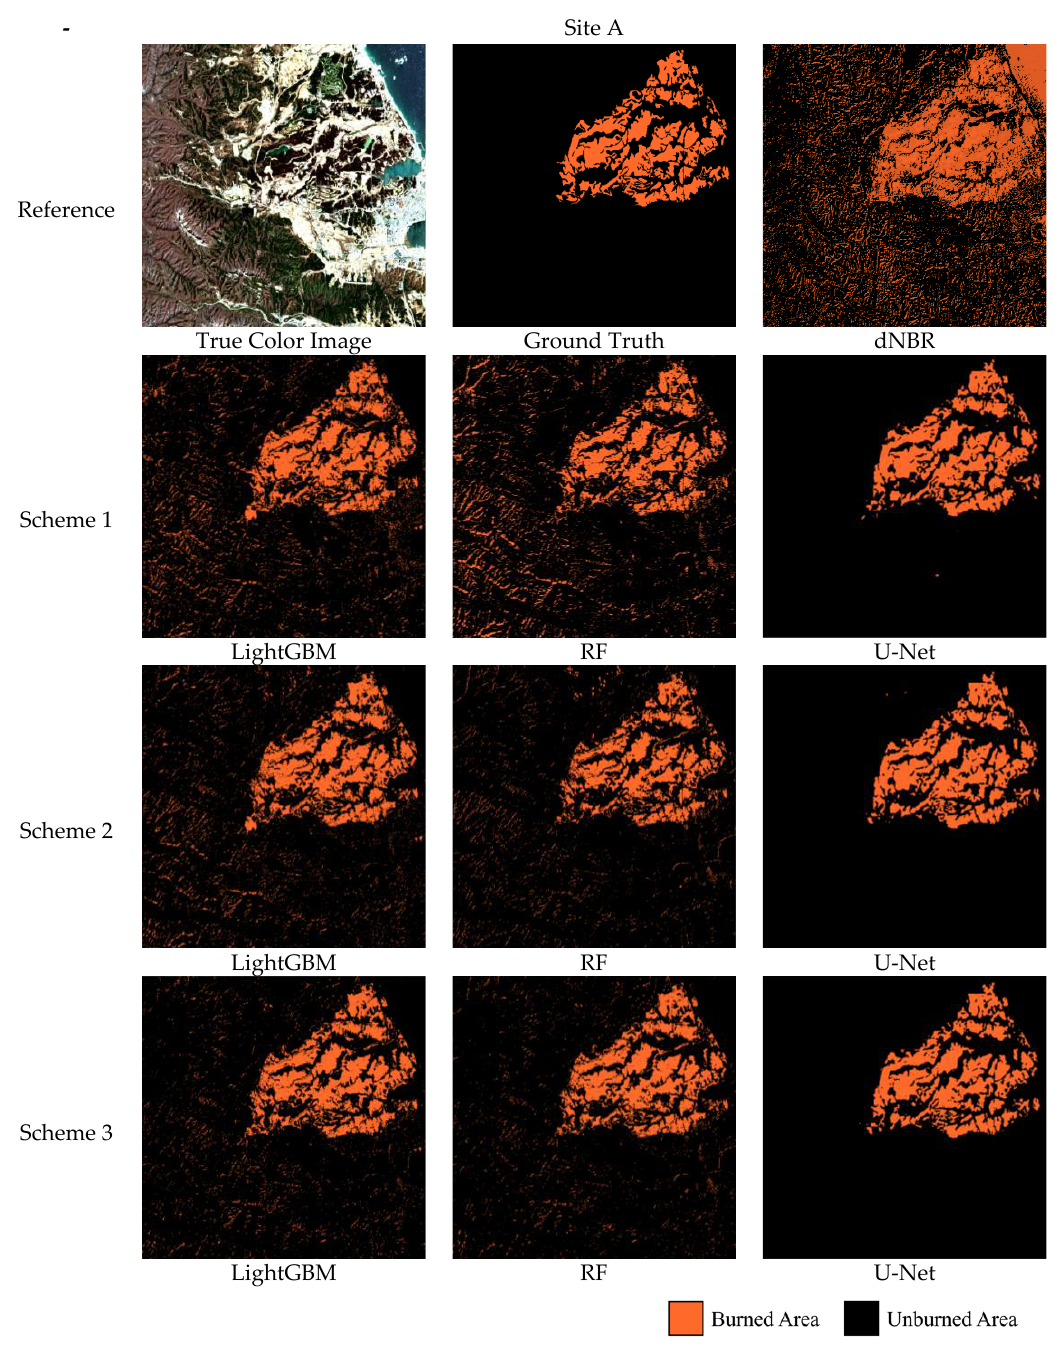
Figure 5. Spatial distribution of burned area detection results in Site A.